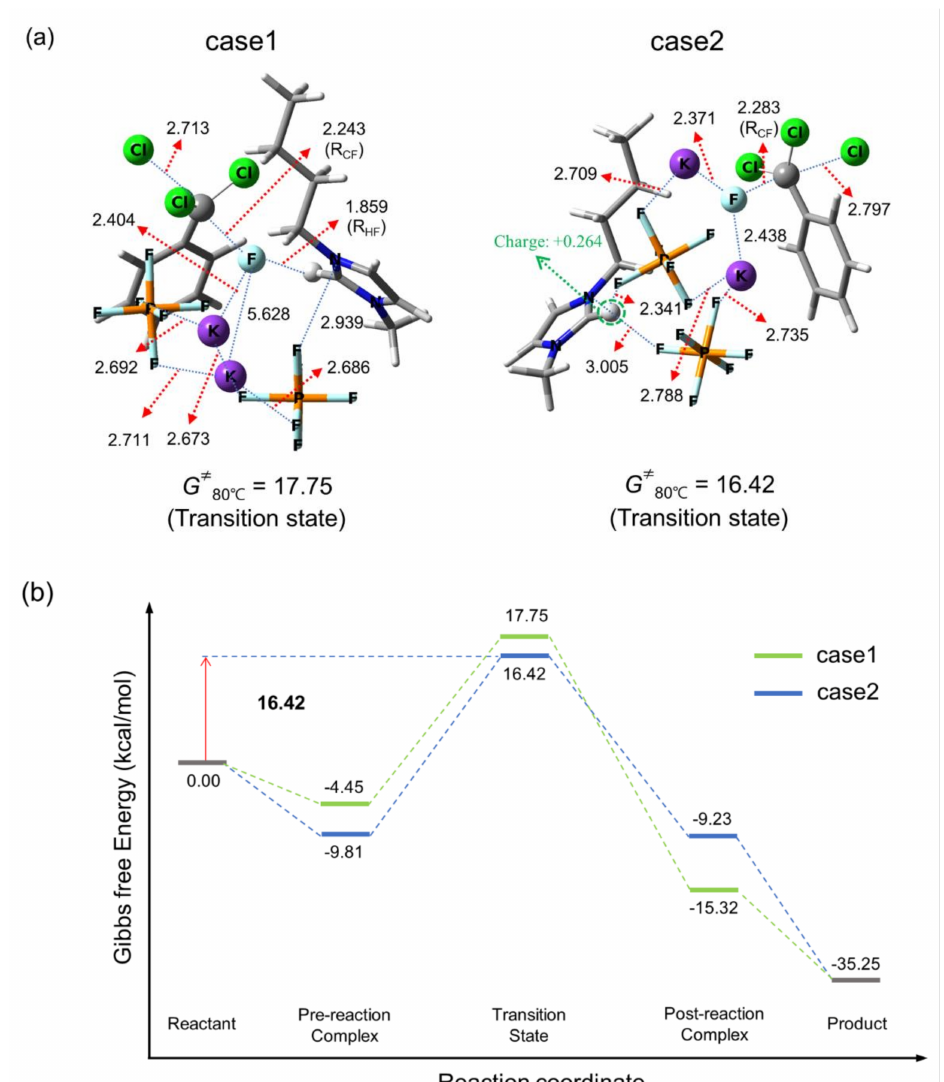
Figure 4. Calculated ( a ) transition states and ( b ) energetics of S N 2 fluorination in [bmim]PF 6 activated by KPF 6 , with substrate:KF:KPF 6 =